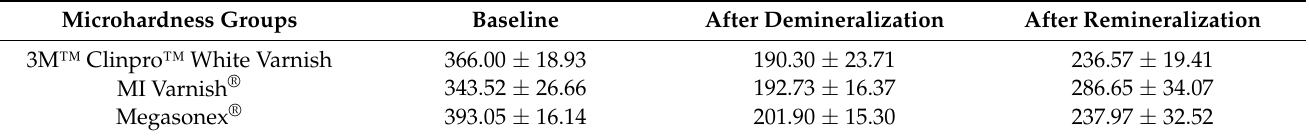
Table 2. Microhardness of the three different groups in three stages (HV 0.1).